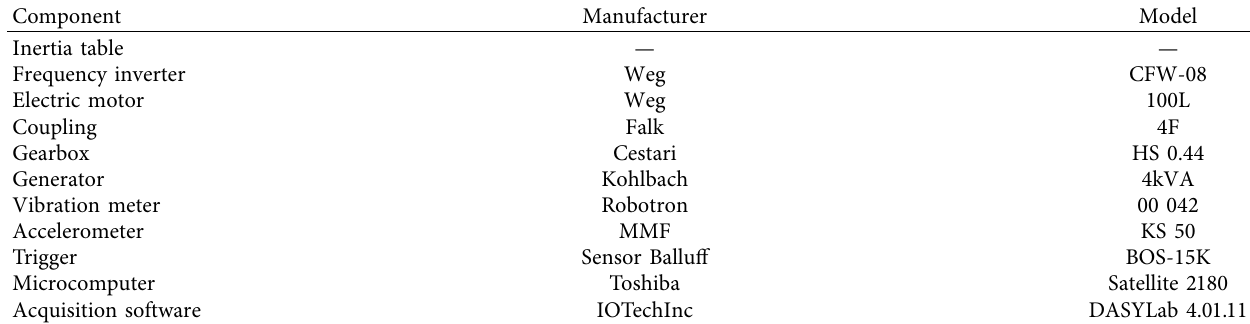
Table 1: Specification of the workbench components.